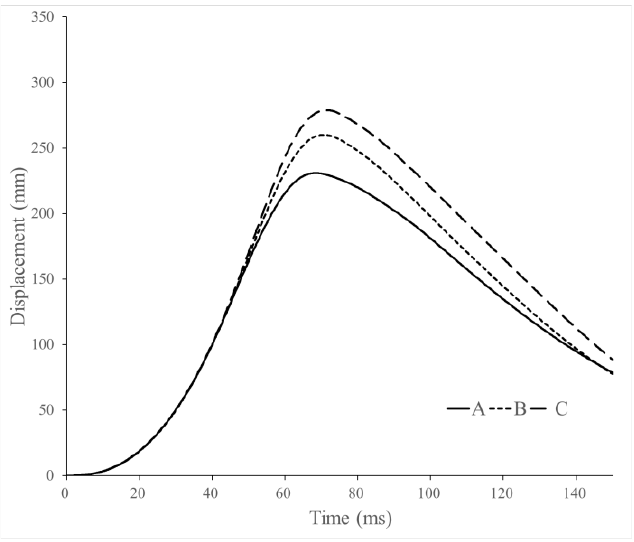
Figure 6. Time courses of the chest displacement using the restraint methods shown in Figures 1 – 3. Table 1. Maximum head, chest, and pelvis accelerations, neck flexion and extension moments, chest deflections, and seatbelt loads using the seatbelt arrangements shown in Figure 1 (test A), Figure 2 (test B), and Figure 3 (test